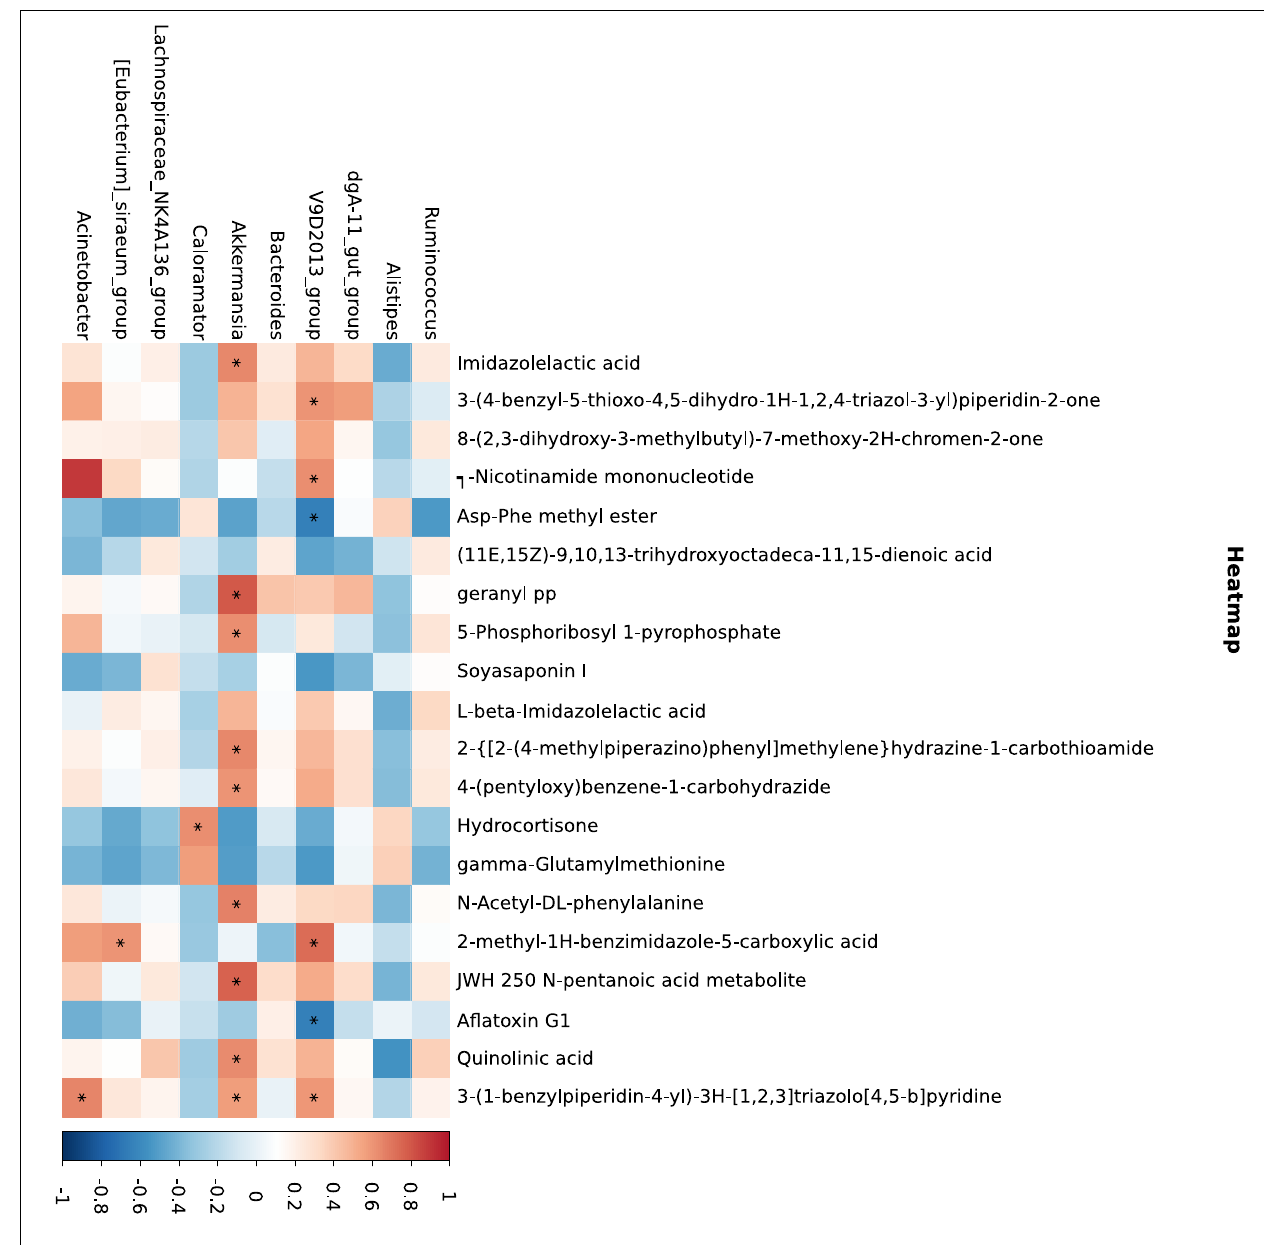
FIGURE 6 | Metabolite and microbial association analyses. The abscissa is the differential metabolite (top 20) and the ordinate is the 16S differential bacteria (top 10). Blue indicates negative correlation, while red indicates positive correlation. ∗ p ≤